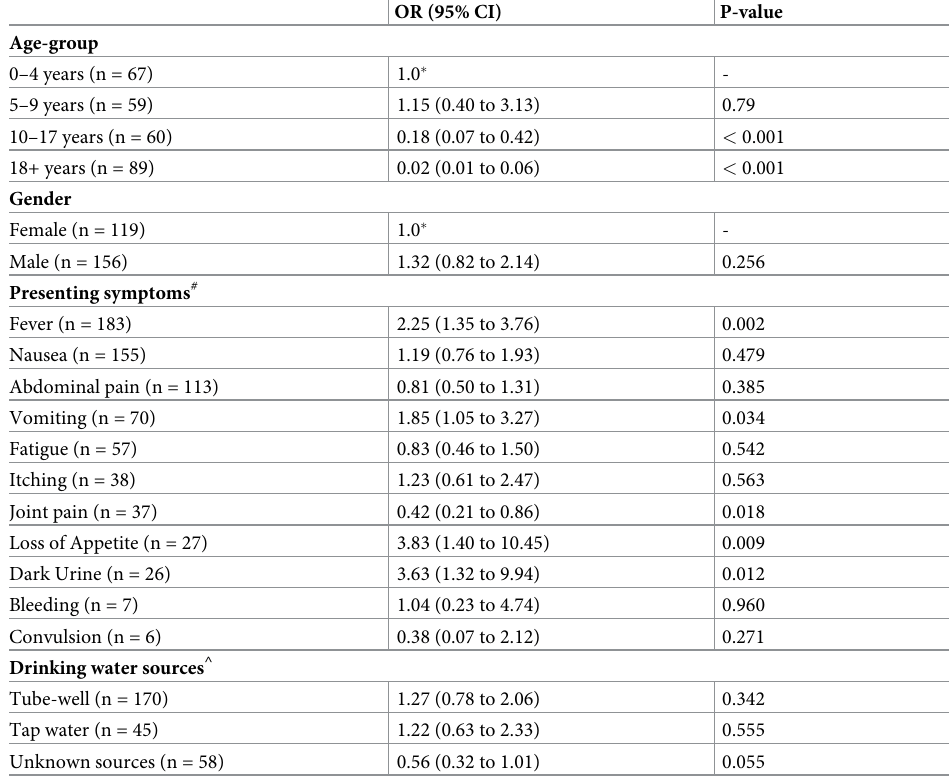
Table 4. Association of hepatitis A seropositivity with age-group, gender, presenting symptoms and drinking water